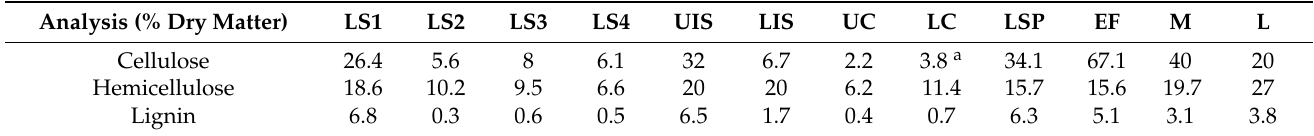
Table 2. Lignocellulosic composition of Enset biomass